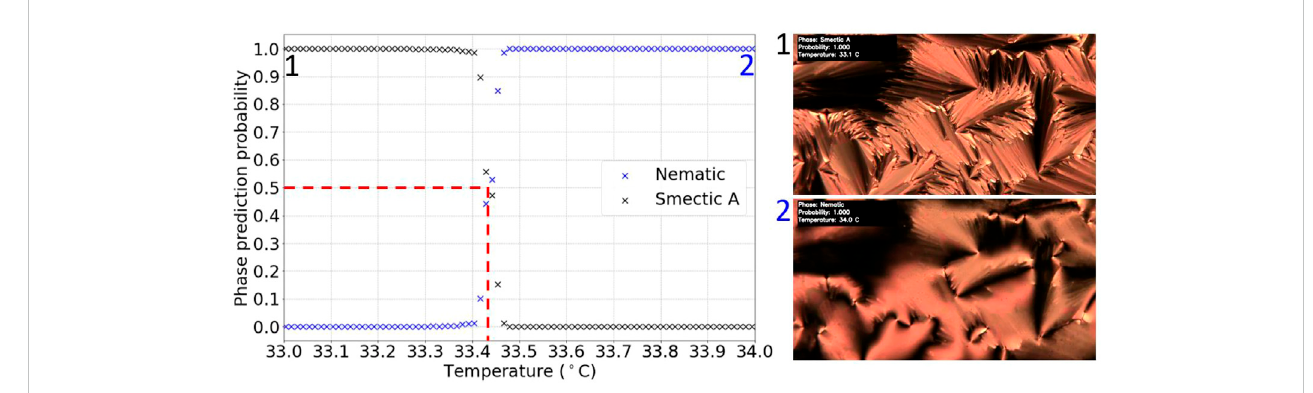
FIGURE 6 Graph of phase prediction probability against temperature for a labelled N-SmA transition test video. The vertical dashed line shows the identi fi ed transition temperature.